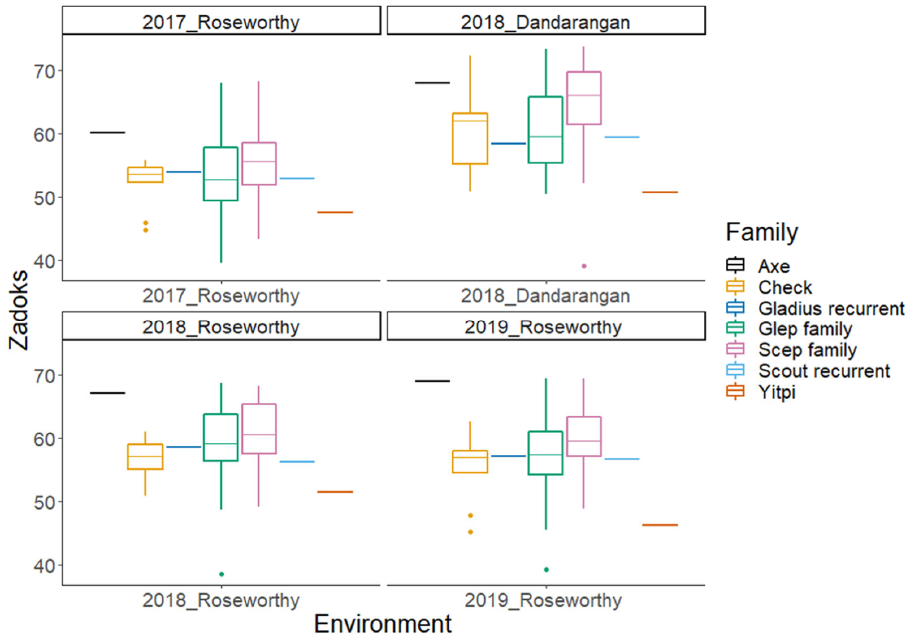
Figure 1. Boxplots of Zadoks’ score (maturity) BLUPs in four different environments for the subset of the Wheat Hub NAM population and the check varieties. The NAM subset population is separated into Gladius and Scout families. BLUPs for Axe and Yitpi represent the selection thresholds for Zadoks’ score.